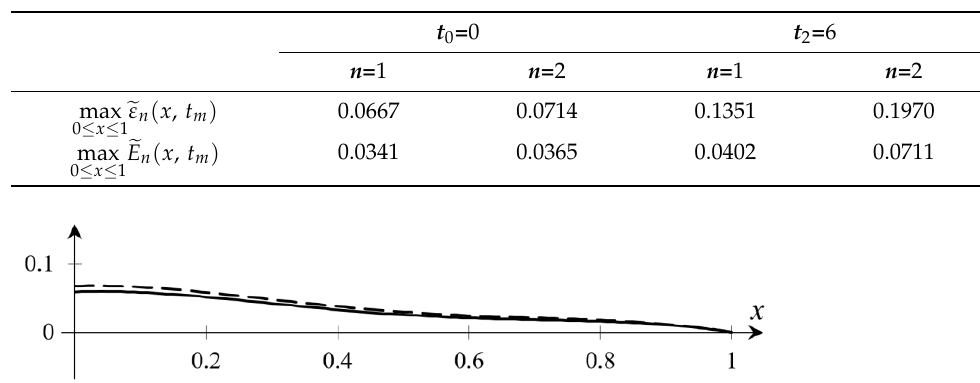
Table 2. Comparison of residuals for ψ m .